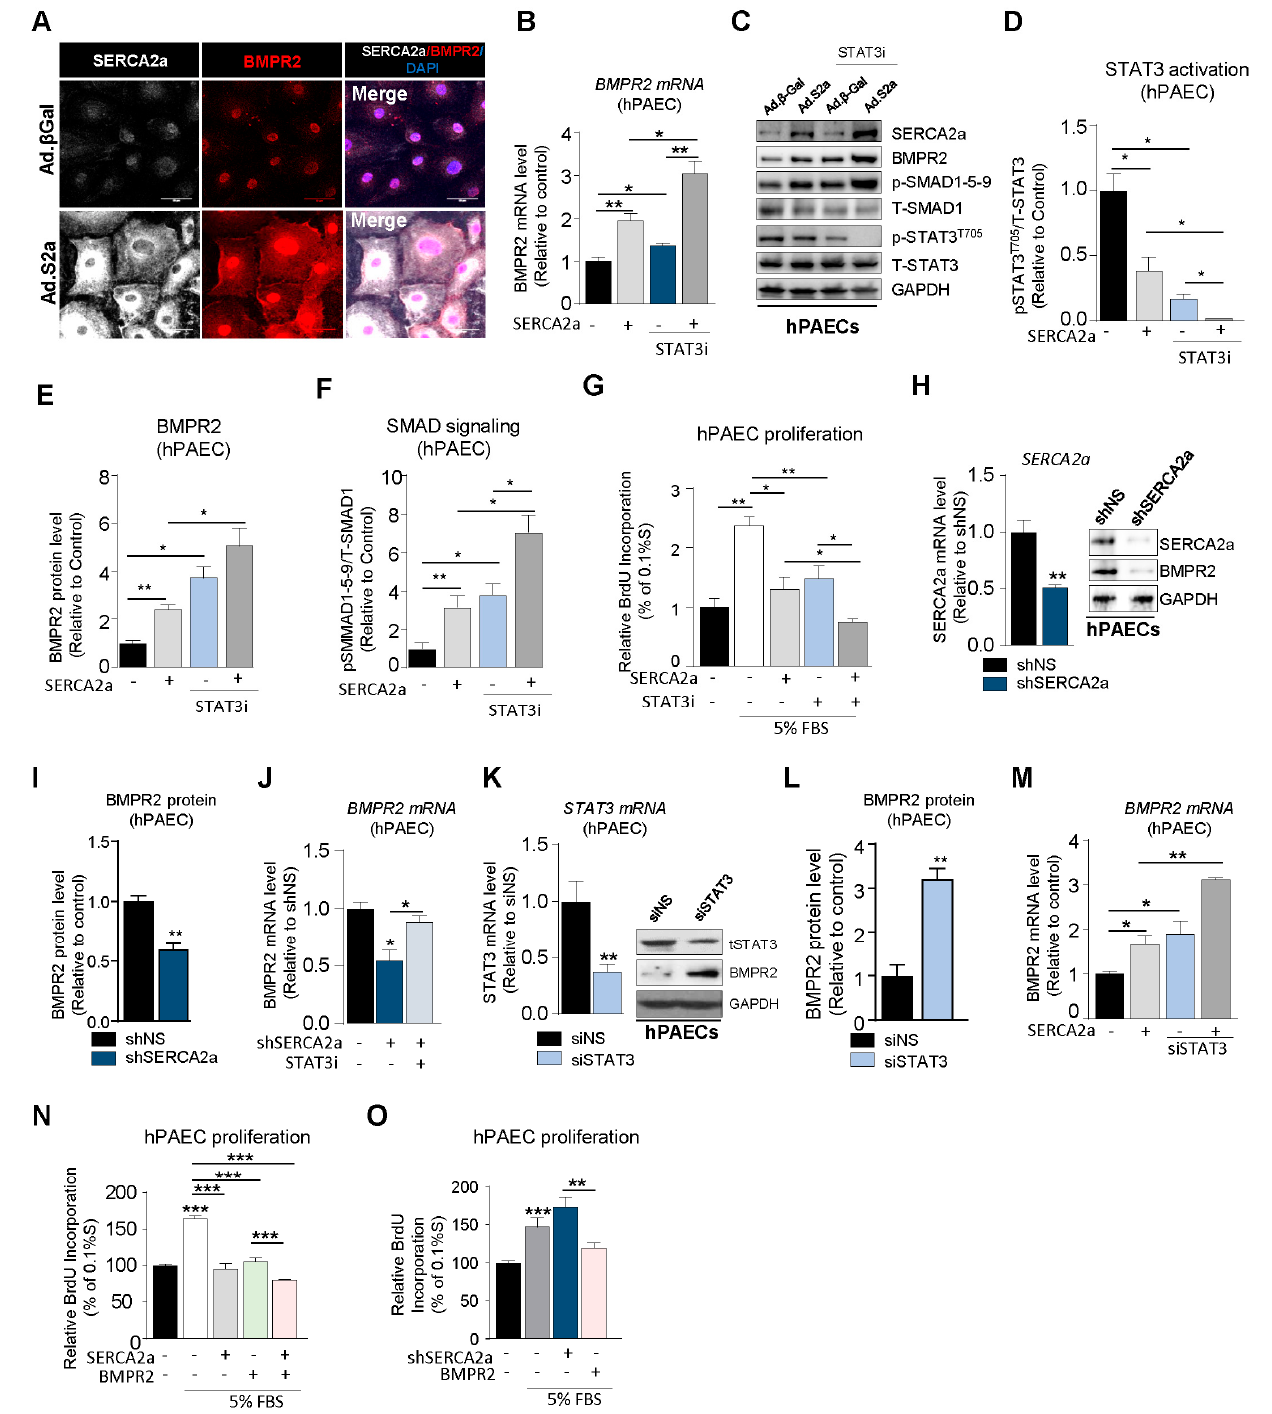
Figure 4. SERCA2a overexpression increases BMPR2 expression in hPAECs. ( A ). SERCA2a (far-red, white color) and BMPR2 (red color) expression was measured by co-immunostaining in hPAECs infected with a control adenovirus encoding β -Galactosidase (Ad. β Gal) or SERCA2a (Ad.S2a). Nuclei were counterstained with DAPI (blue). Scale bar: 50 μ m. ( B ). BMPR2 mRNA levels were measured by RT-qPCR in hPAECs infected with Ad.S2a or Ad. β Gal for 24 hr and were treated with a STAT3 inhibitor (STAT3i; 1 μ M) for 48 h, n = 3. ( C ). Representative immunoblots of SERCA2a, BMPR2, phospho-SMAD1-5-9 (p-SMAD-1-5-9), phospho-STAT3 T705 (p-STAT3 T705 ), Total-SMAD1 (T-SMAD1), Total-STAT3 (T-STAT3), and GAPDH in hPAECs in the indicated conditions. ( D – F ). Bar graph represents the quantification of p-STAT3 T705 ( D ), BMPR2 ( E ), p-SMAD1-5-9 ( F ), and normalized to T-STAT3, GAPDH, and T-SMAD1, respectively, n = 3. ( G ). Proliferation levels were measured by BrdU assay in hPAECs overexpressing SERCA2a alone for 48 h and/or were treated with a potent STAT3 inhibitor (STAT3i, 1 μ M) for 72 h in a media containing 0.1% or 5% FBS, n = 4. ( H ). SERCA2a mRNA (left) or protein